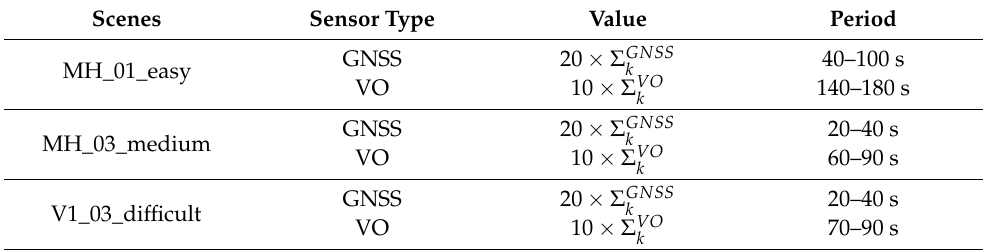
Table 7. Different sensor simulation error parameter